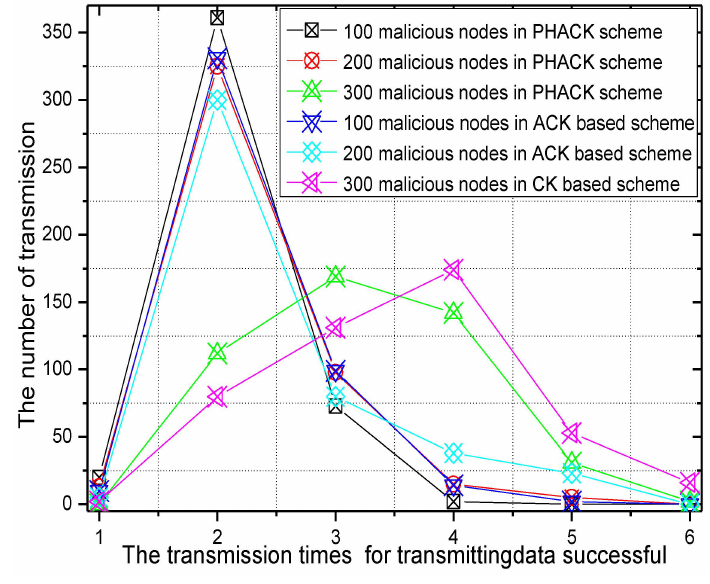
Figure 12. The transmission times for successful data transmission.